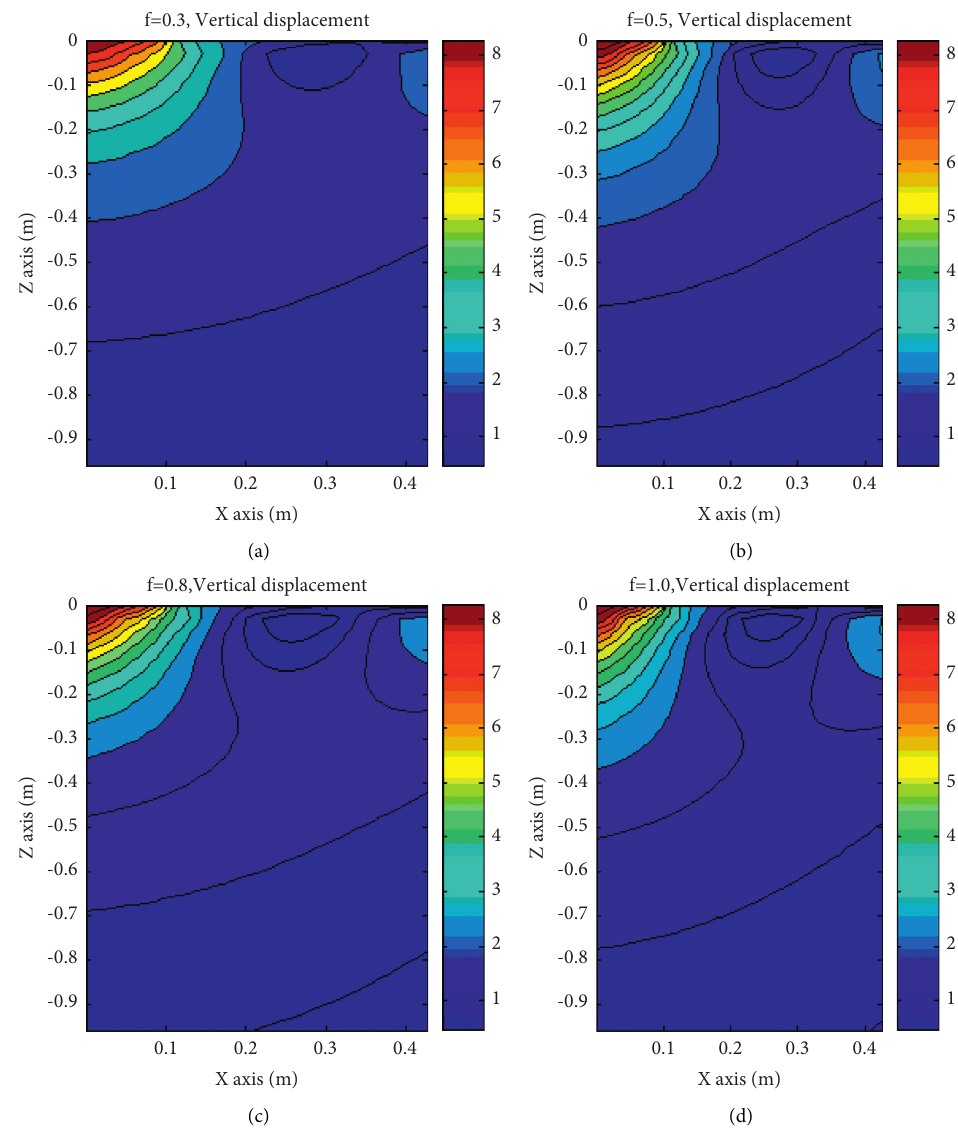
Figure 4: Vertical displacement nephogram under different friction coefficients. (a) f � 0.3. (b) f � 0.5. (c) f � 0.8. (d) f �